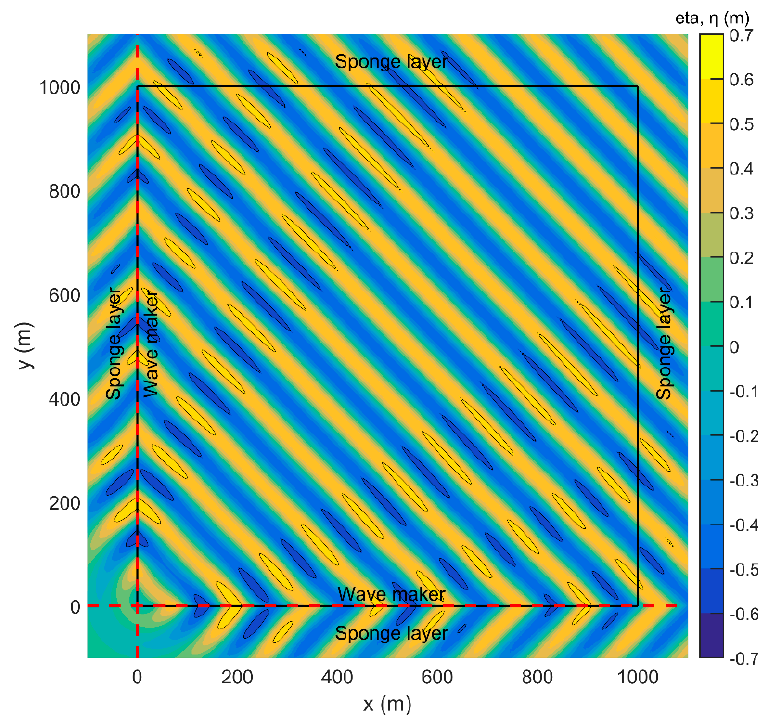
Figure 1. Water surface elevation, η , for regular incident waves with a wave height of H = 1 m, wave period of T = 12 s, and wave propagation angle of θ = 45° affected by diffraction patterns due to the intersection of the two wave generation lines and the interaction with the lateral sponge layers.